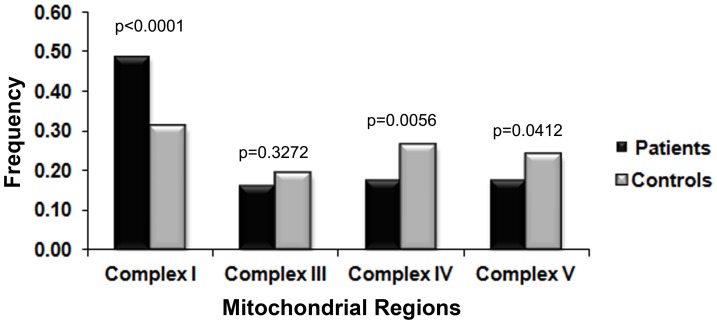
Distribution of non-synonymous unique segregating sites (USS) in the mtDNA complexes.The frequency of non-synonymous USS was significantly higher (p<0.0001) in patients compared to controls in the case of Complex I. Marginally higher segregating sites were observed in controls for Complex IV and Complex V.